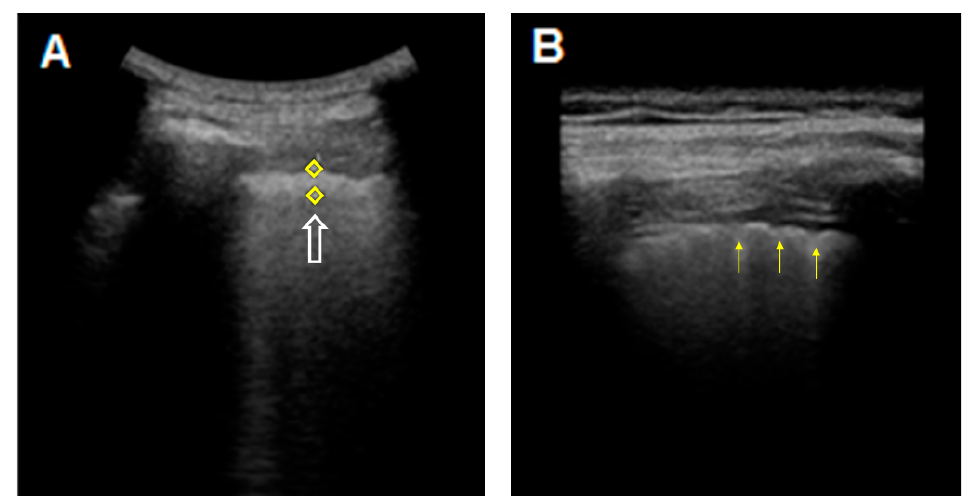
Figure 2. TUS images of the hyperechoic pleural line in a patient with an HRCT pattern of Usual Interstitial Pneumonia (UIP). ( A ) The hyperechoic pleural line (white arrow) appears thickened